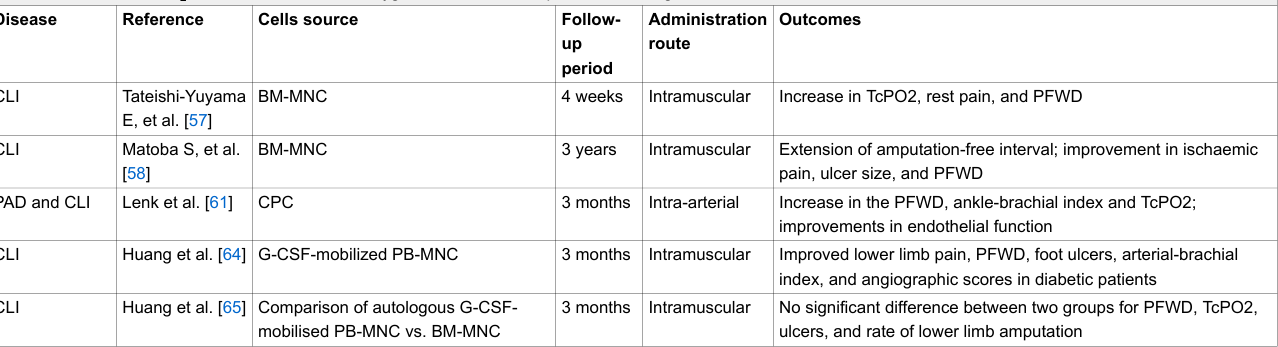
Table 1 Randomised, controlled clinical trials using BM- or peripheral blood-derived progenitor cells for therapeutic neovascularisation. CLI, critical limb ischaemia; PAD, peripheral artery disease; BM-MNC, bone marrow mononuclear cells; CPC, circulating progenitor cells; G-CSF, granulocyte colony-stimulating factor; PB-MNC, peripheral blood mononuclear cells; TcPO 2 , transcutaneous tissue oxygen tension; PFWD, pain free walking